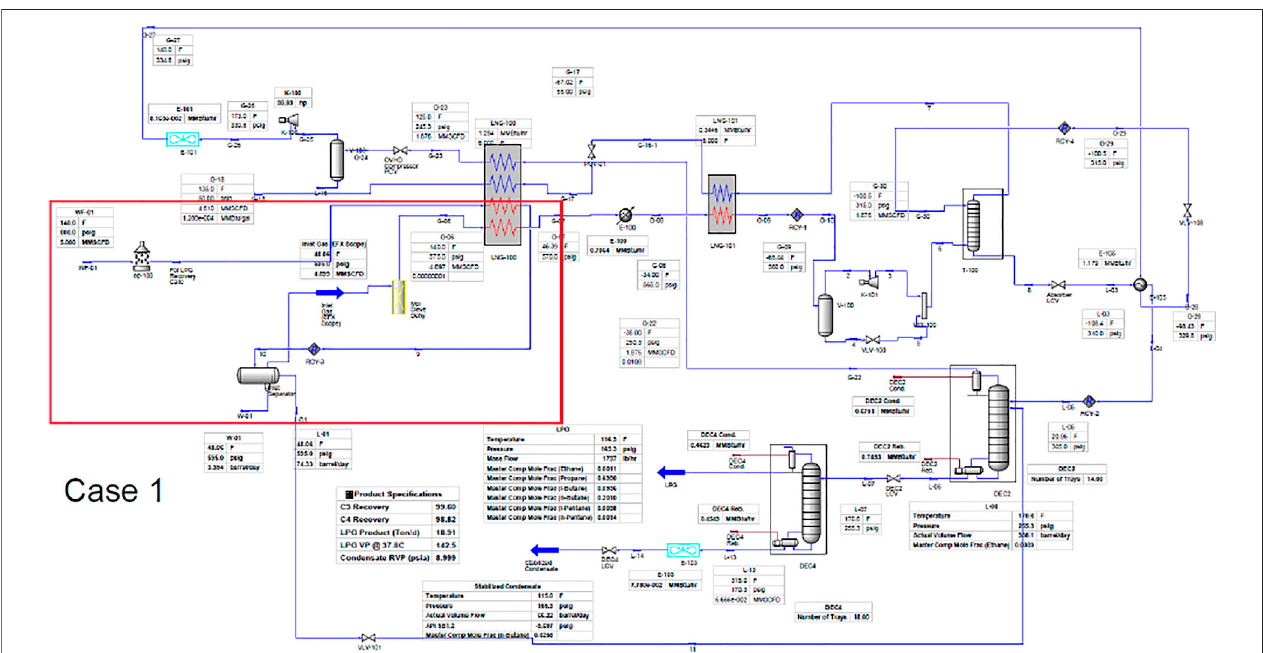
FIGURE 3 | Process fl ow diagram and Aspen HYSYS model for case study 1.